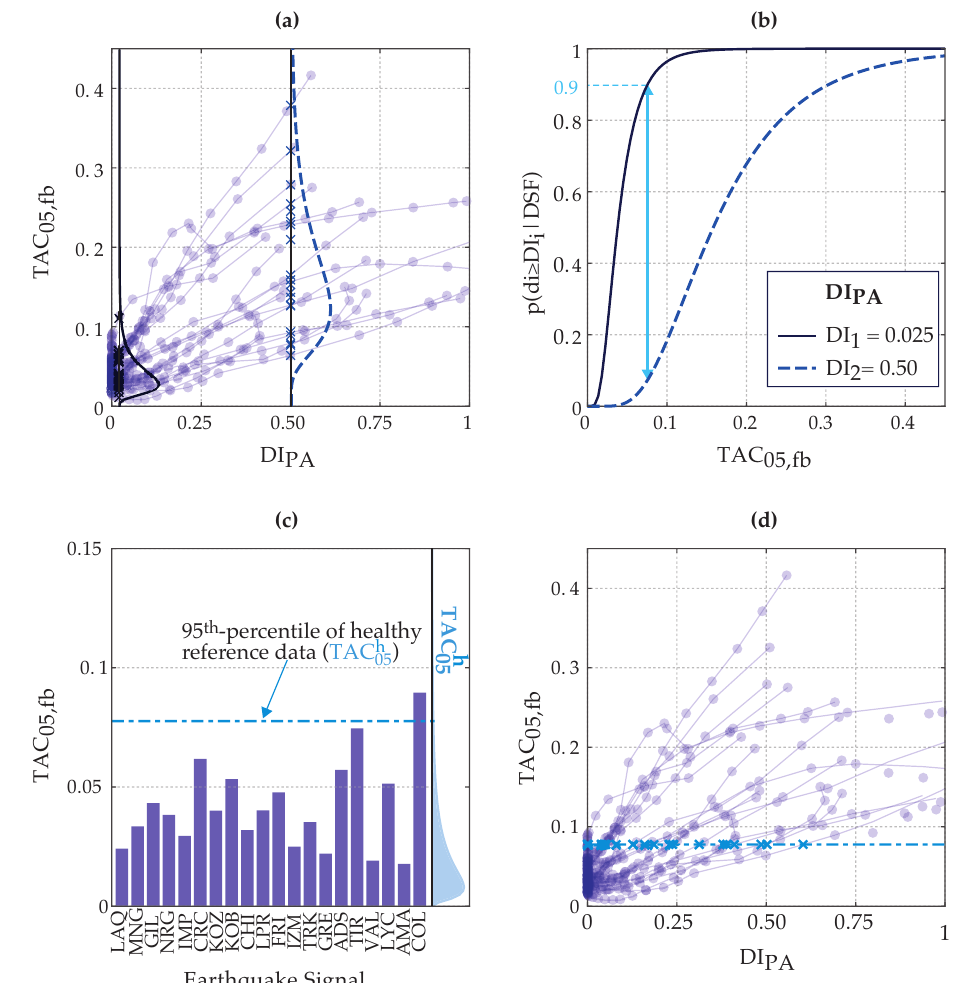
Figure 5. Derivation of performance indicators for the comparative assessment of the DSFs, illus- trated with respect to the Park–Ang damage index ( DI PA ). Correlation between each DSF and the DI ( a ); separation between no damage ( DI PA = 0.025) and extensive damage ( DI PA = 0.50), using probability of exceeding the respective DSF values ( a , b ); false damage detection ( c ); and minimum value of DI PA , for which damage is detected ( d ). The two last indicators ( c , d ) require a previous characterization of the behavior of the healthy structure under AVs ( TAC h 05